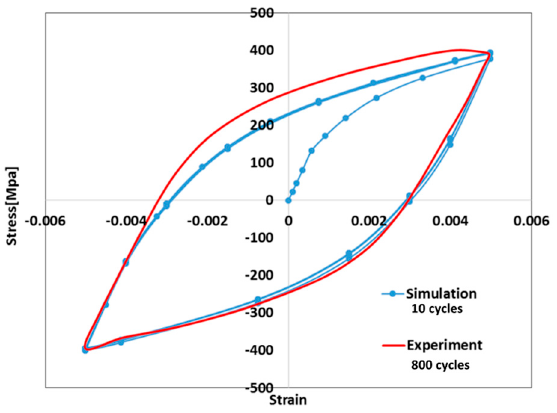
Figure 8. Numerical simulation of stabilised stress-strain hysteresis loop in comparison with the experiment.